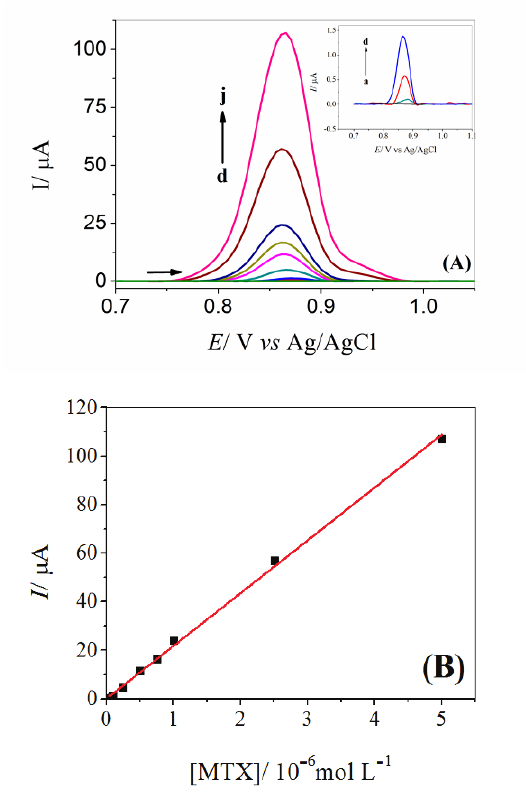
Figure 6. (A) DPAdSV for MWCNTs-DHP/GC electrode in presence of 0 (a), 0.05 (b), 0.075 (c), 0.10 (d), 0.25 (e), 0.5 (f), 0.75 (g), 1.0 (h), 2.5 (i) and 5.0 × 10 -6 (j) mol L -1 MTX (v = 50 mV s -1 ; a = 70 mV; t = 20 mV) in 0.1 mol L - 1 H and accumulation time of 300 s, and (B) analytical